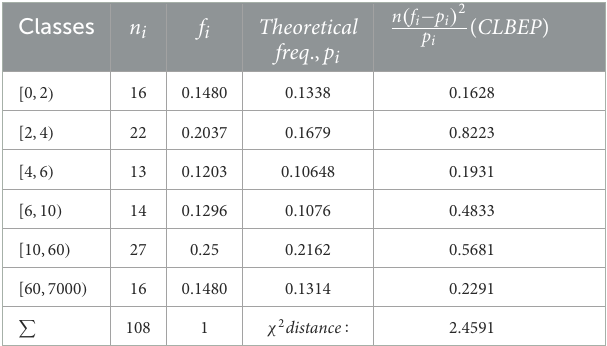
TABLE 5 Estimated values of fitted models and − LL , AIC , AICc , and BIC data set I.